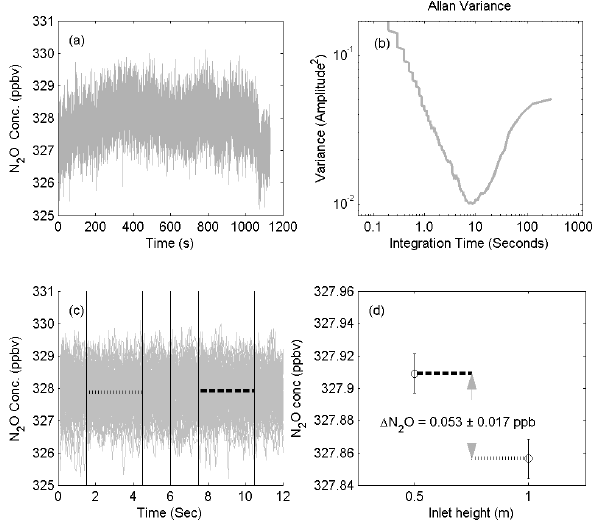
Fig. 5. (a) Example of a 1200s time series of 10Hz N 2 O determi- nations measured by the N 2 O analyser (TDLAS), which was inte- grated within the FS-NOMAS; (b) Allan variance as a function of averaging time; (c) the 1200s time series folded into 100 sequen- tial 12s time series where the dashed and dotted lines designate the average N 2 O mole fraction measured at 0.5m ( z 1 ) and 1.0m ( z 2 ) heights, respectively; (d) average and standard deviation of the N 2 O determinations for each height and calculated 1 N 2 O ( ± SE 1 N Vertical error bars indicate the normal distribution with µ =average N 2 O mole fraction and σ =standard deviation for the populations of N 2 O determinations collected at each